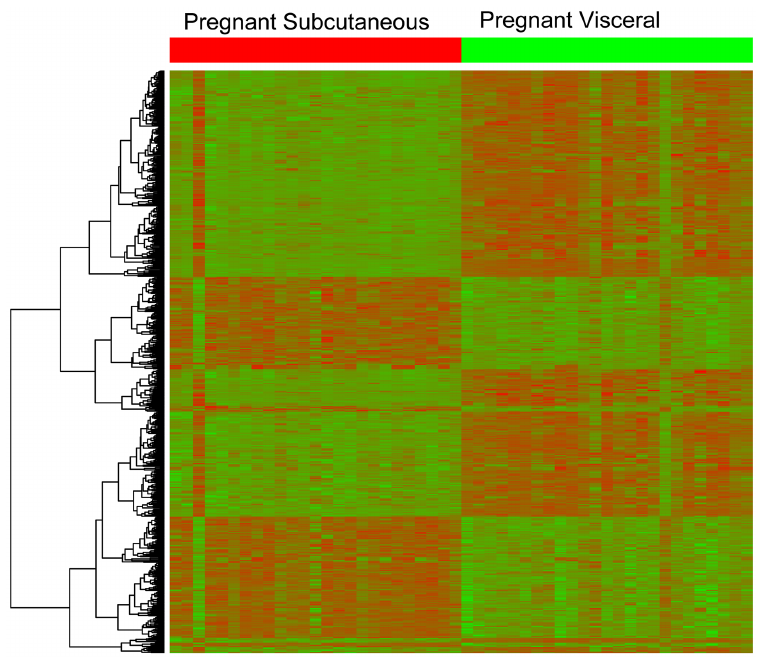
Fig 2. Heat map representing fat depot-specific differences in gene expression of pregnant women. The heat map uses a color scale to show the consistency of the expression levels within each group of samples as well as the differences between the groups that led to positive test results.